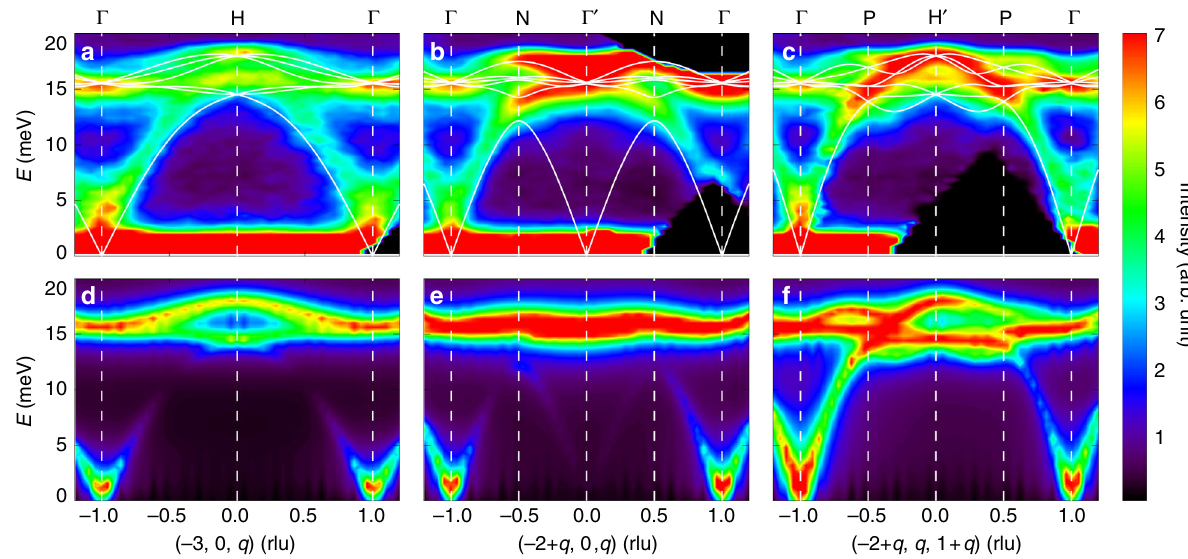
Fig. 2 Experimental and calculated spin-wave excitations. a – c Inelastic neutron scattering results of the spin excitation spectra measured at T = 5 K along [001], [101], and [111] directions, respectively. d – f Calculated magnetic spectra using the linear-spin-wave theory based on a set of parameters with J 1 = 9.07, J 2 = 0.89, J 3 = − 1.81, J 4 = 1.91, J 5 = 0.09, and J 6 = 1.83 meV. The uncertainty of the parameters is about 6%. The calculated dispersions are plotted as solid lines in a – c . The wave vector Q is expressed as Q = (2 π / a , 2 π / b , 2 π / c ) reciprocal lattice unit (rlu) with a = b = c = 9.537(3) Å. Vertical dashed lines indicate the Q positions illustrated in Fig.